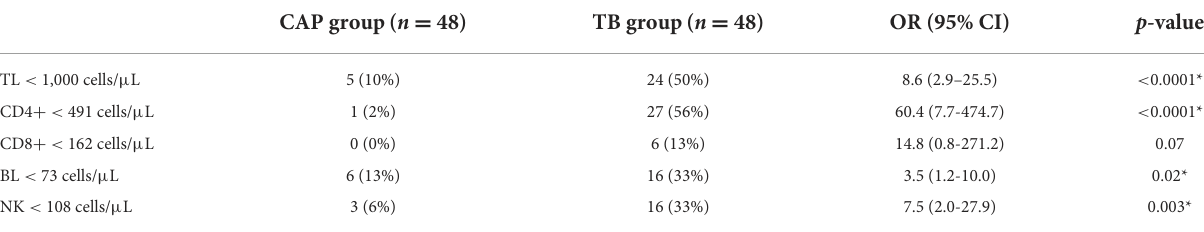
TABLE 2 “Odds ratios of finding an absolute number of total lymphocytes and their subpopulations below normal ranges in the TB group compared to the CAP group.” CAP group ( n =